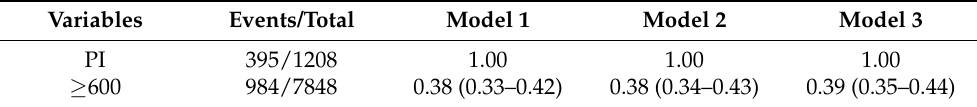
Table 2. Associations between study participants with a PAV ≥ 600 MET-minutes/week and impaired physical function. Values are hazard ratios (95% confidence intervals) unless otherwise noted.